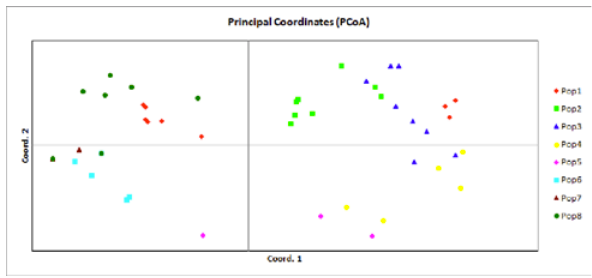
Figure 2. PCoA plot of ISSR data in Z. Jujube populations.